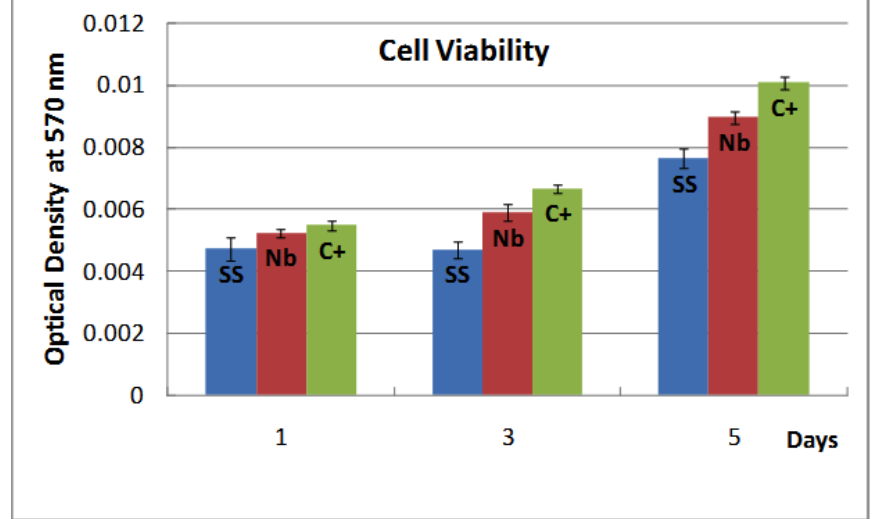
Figure 7. Cell Viability as a function of the incubation time. The optical density at 570 nm is directly proportional to the number of viable cells. (* p < 0.01 and ** p <